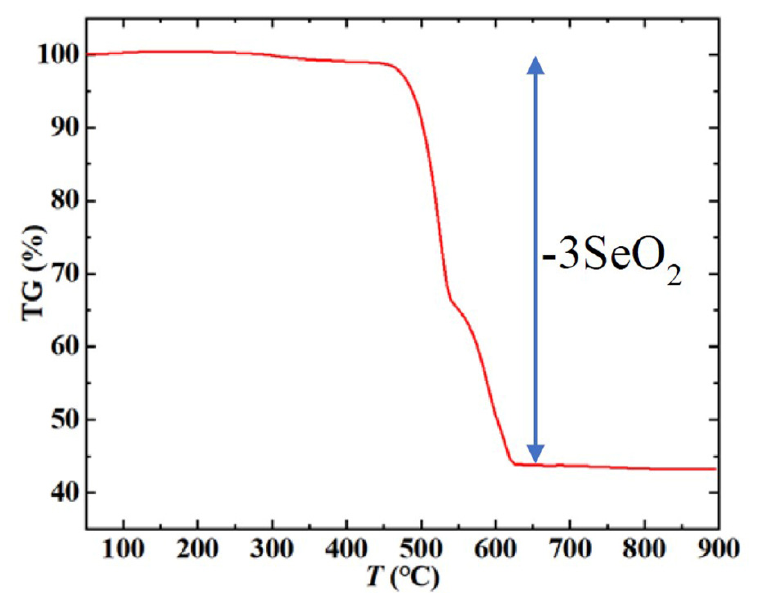
Figure 6. The thermogravimetric curve of Mn 3 O(SeO 3 ) 3 , which shows that the residual product of decomposition above 630 °C is Mn 3 O 4 . decomposition above 630 ◦ C is Mn 3 O 4